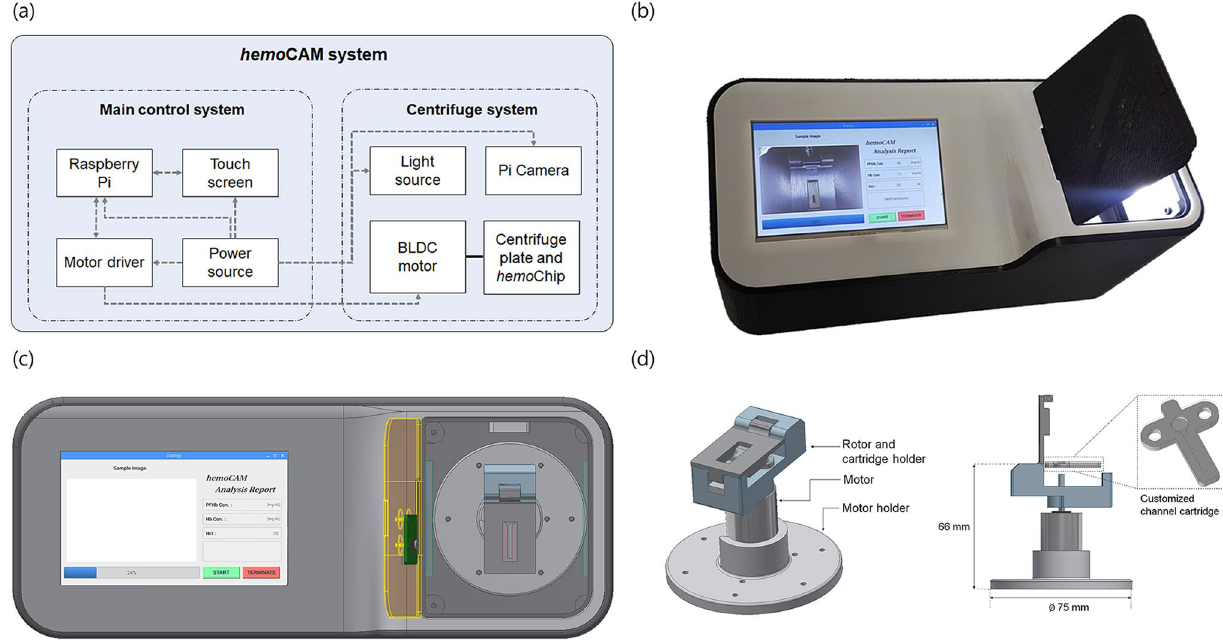
Figure 1. Point-of-care device for hematological analysis. ( a ) Schematic of the device, which is separated into two parts (main control system and centrifuge system). ( b ) The prototype of the device. ( c ) Top view of the device. The left side shows the touch screen of the main control system. The centrifuge system is on the right side, and the camera module is placed on a cover above the centrifuge system to obtain a channel image of the cartridge. ( d ) The centrifuge system consists of motor, motor holder, rotor, and cartridge holder. A customized channel cartridge is fitted to the cartridge